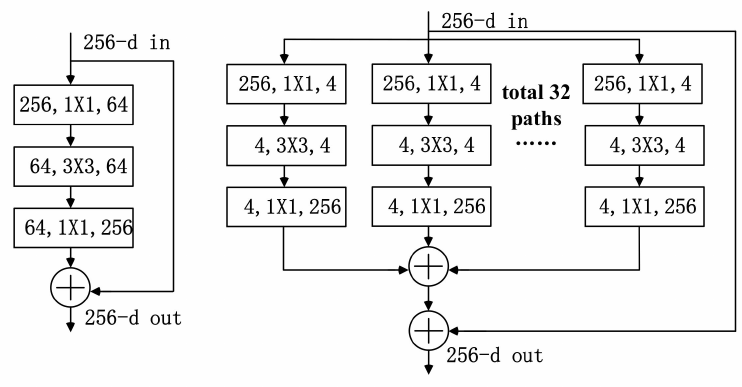
Figure 3. The comparison structure of ResNet ( left ) and ResNeXt ( right ) network blocks. (2) Perfomance of ResNeXt is better than ResNet.